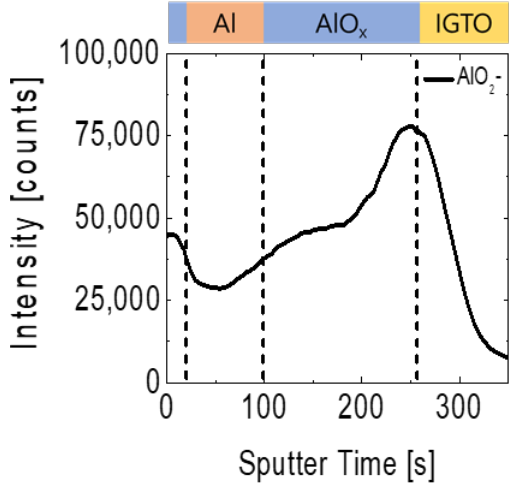
Figure 6. Time-of-flight secondary ion mass spectrometry (ToF-SIMS) negative ion depth profile for AlO 2 -ions obtained from the 8 nm thick Al capping layer in the fabricated Al-capped IGTO TFT.